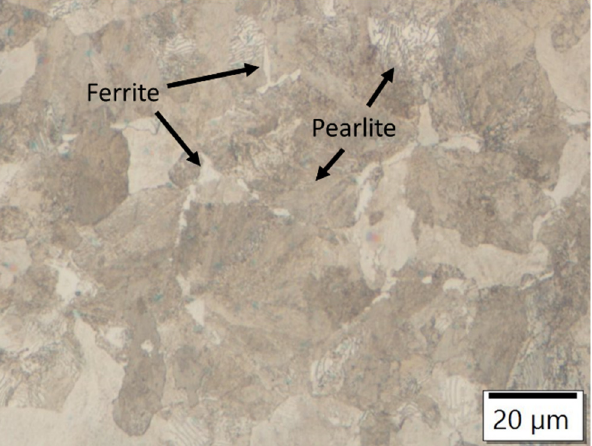
Figure 1. Ferritic–pearlitic microstructure of as received 51CrV4 steel sample, etched with 5 vol. % Nital. Cylindrical samples with dimensions of Ø4 mm × 10 mm were made for dilatometry